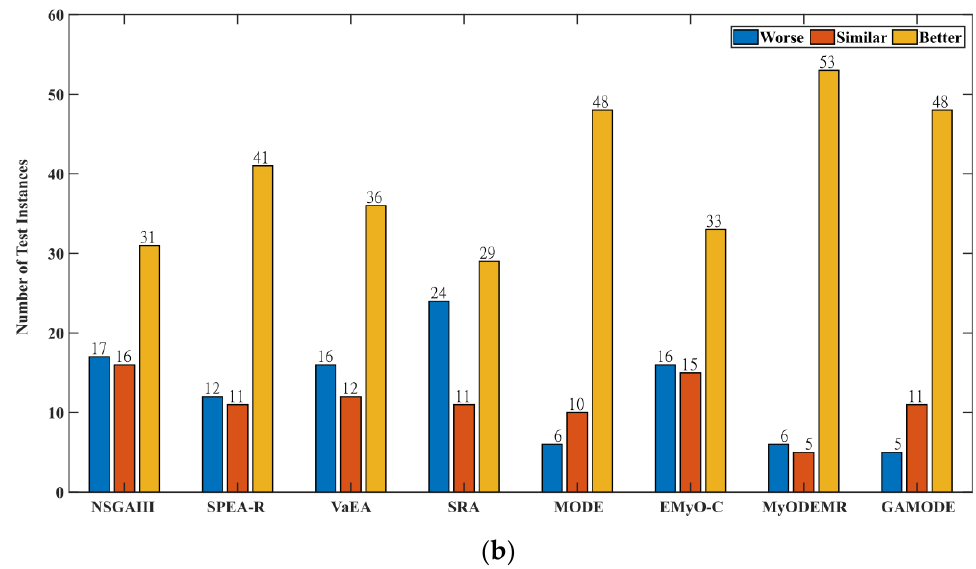
Figure 3. Wilcoxon signed-rank tests at a 5% significance level with respect to the HV for the DTLZ and WFG problems using ad-GrMODE and state-of-the-art algorithms: ( a ) ad-GrMODE1* compared with state-of-the-art algorithms; ( b ) ad-GrMODE2* compared with state-of-the-art algorithms.